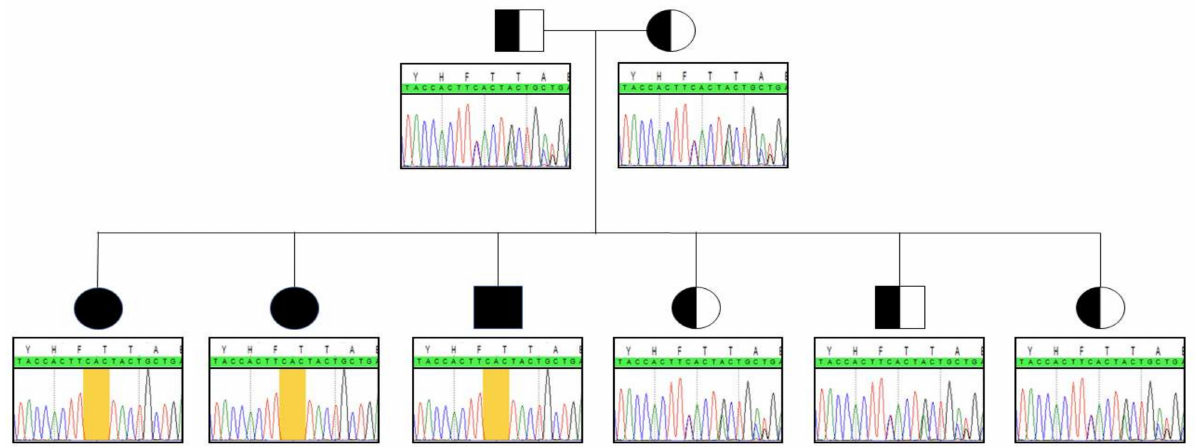
Figure 1. Segregation analysis within the family. Yellow frame indicates the location of the